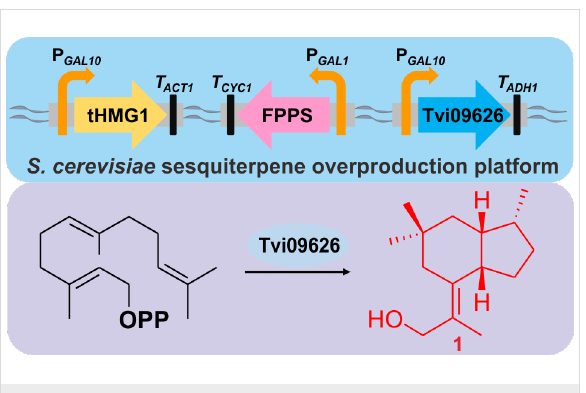
Figure 1: Schematic diagram of the S. cerevisiae sesquiterpene over- production platform and the products of